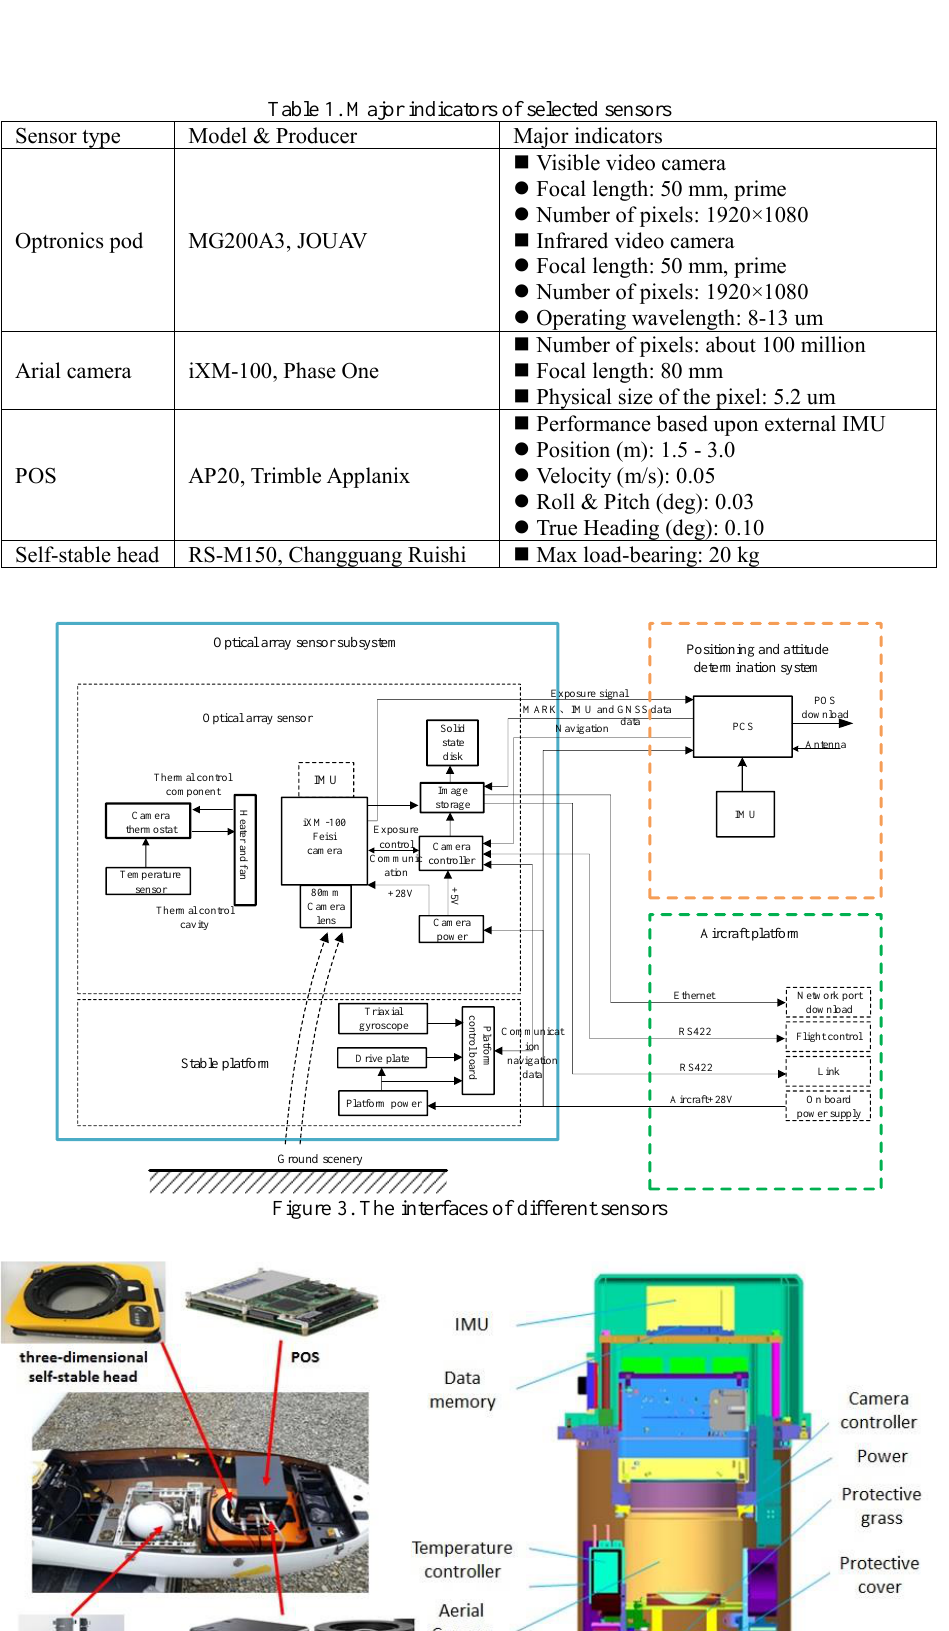
Figure 4. The integrated relation of different